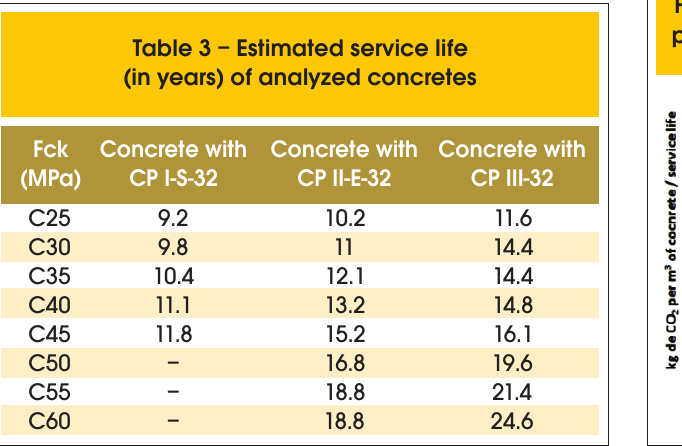
Figure 9 – Relationship between the embodied CO 3 per m and the service life of each type of